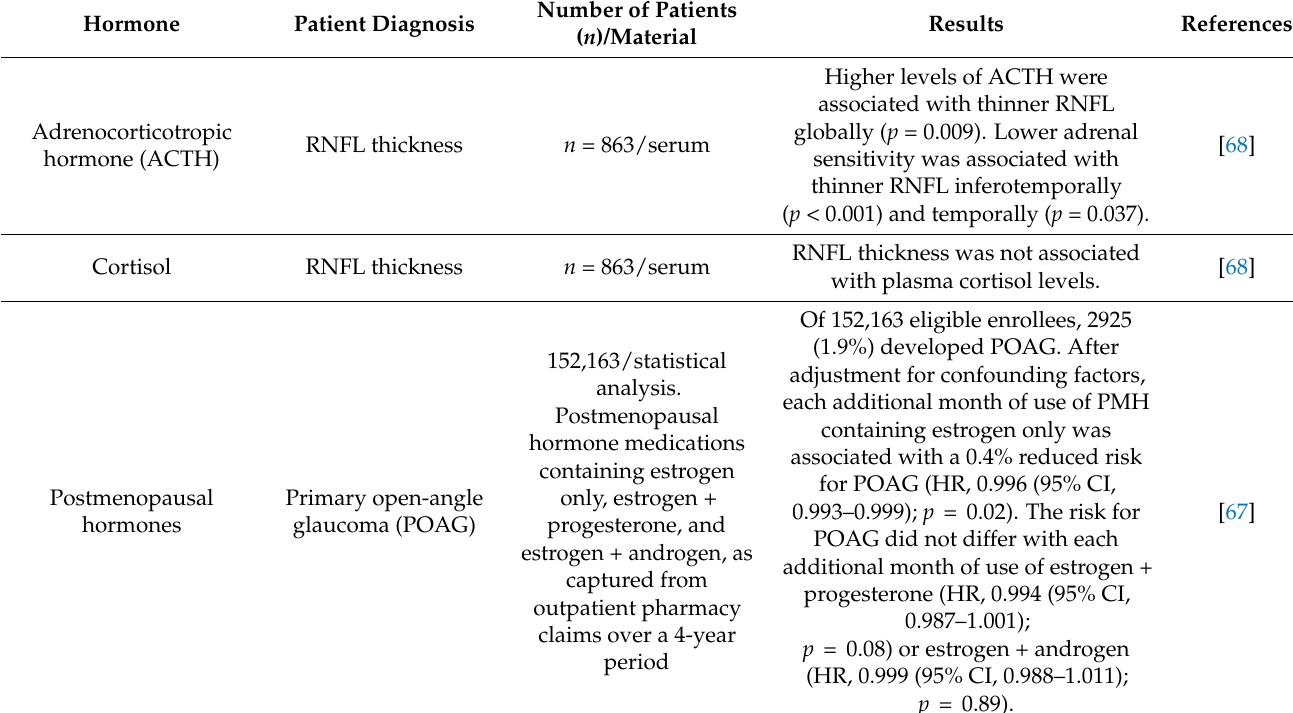
Table 4. Hormones and enzymes evaluated as potential biomarkers in